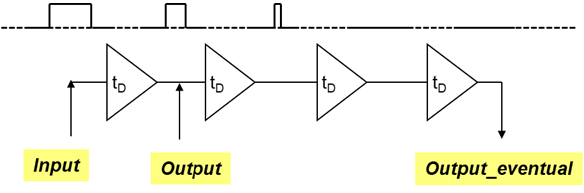
Figure 3. Pulse width filtering in a delay